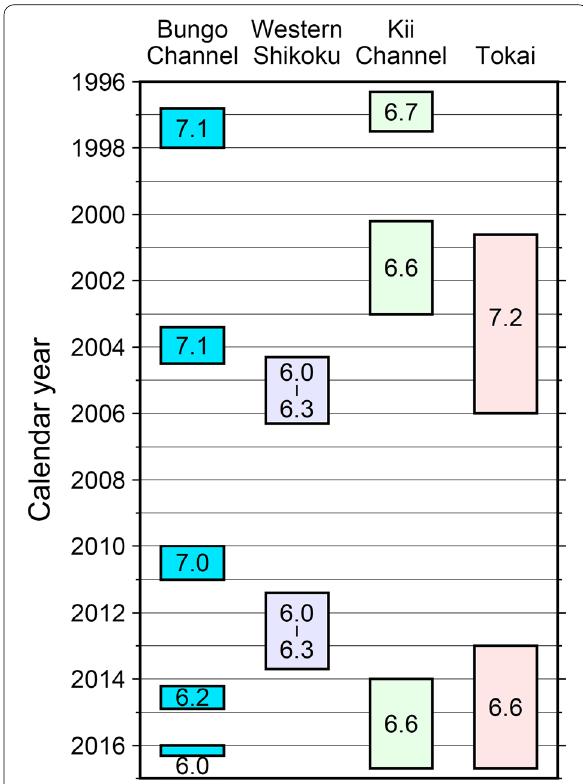
Fig. 3 Schematic timeline of LSSEs along the Nankai Trough together with the moment magnitudes, from Ozawa (2017) except for the 2000–2002 Kii Channel LSSE, which is from Kobayashi